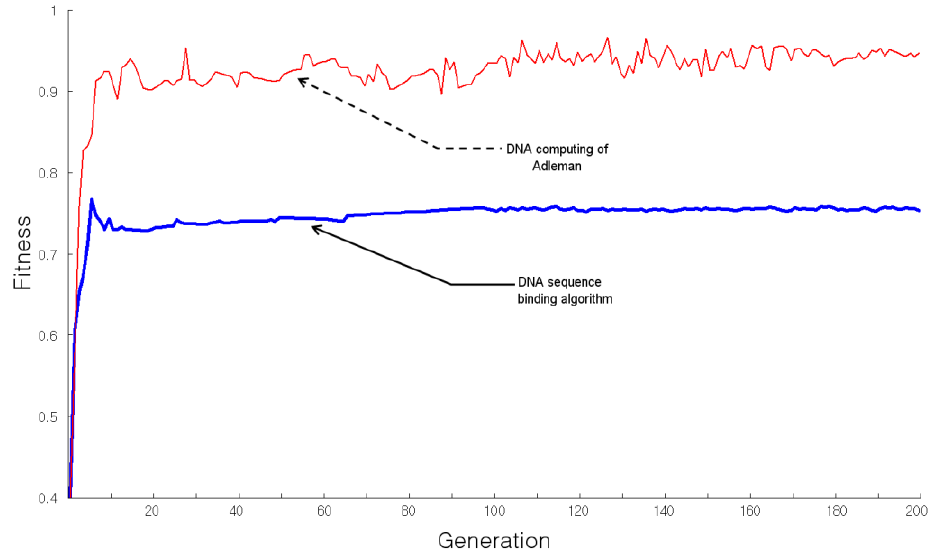
Figure 6. Generation Fitness.